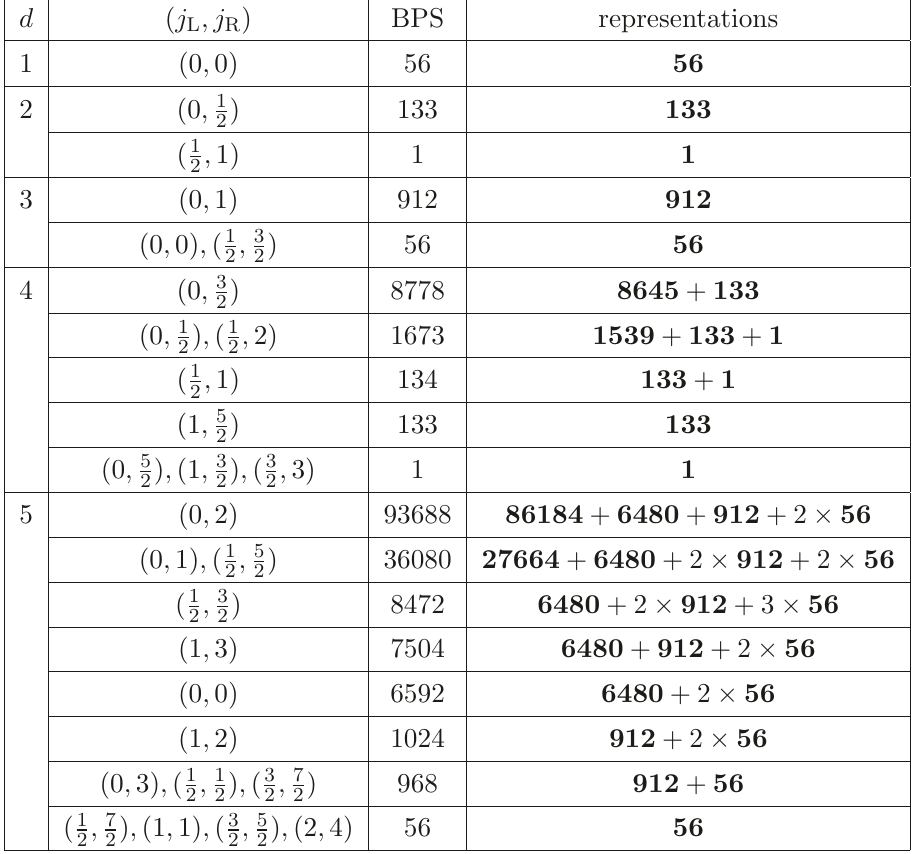
Table 5 . The constituent representations for the total BPS indices of the (2 , 1 , 2 , 1) model for 1 ≤ d ≤